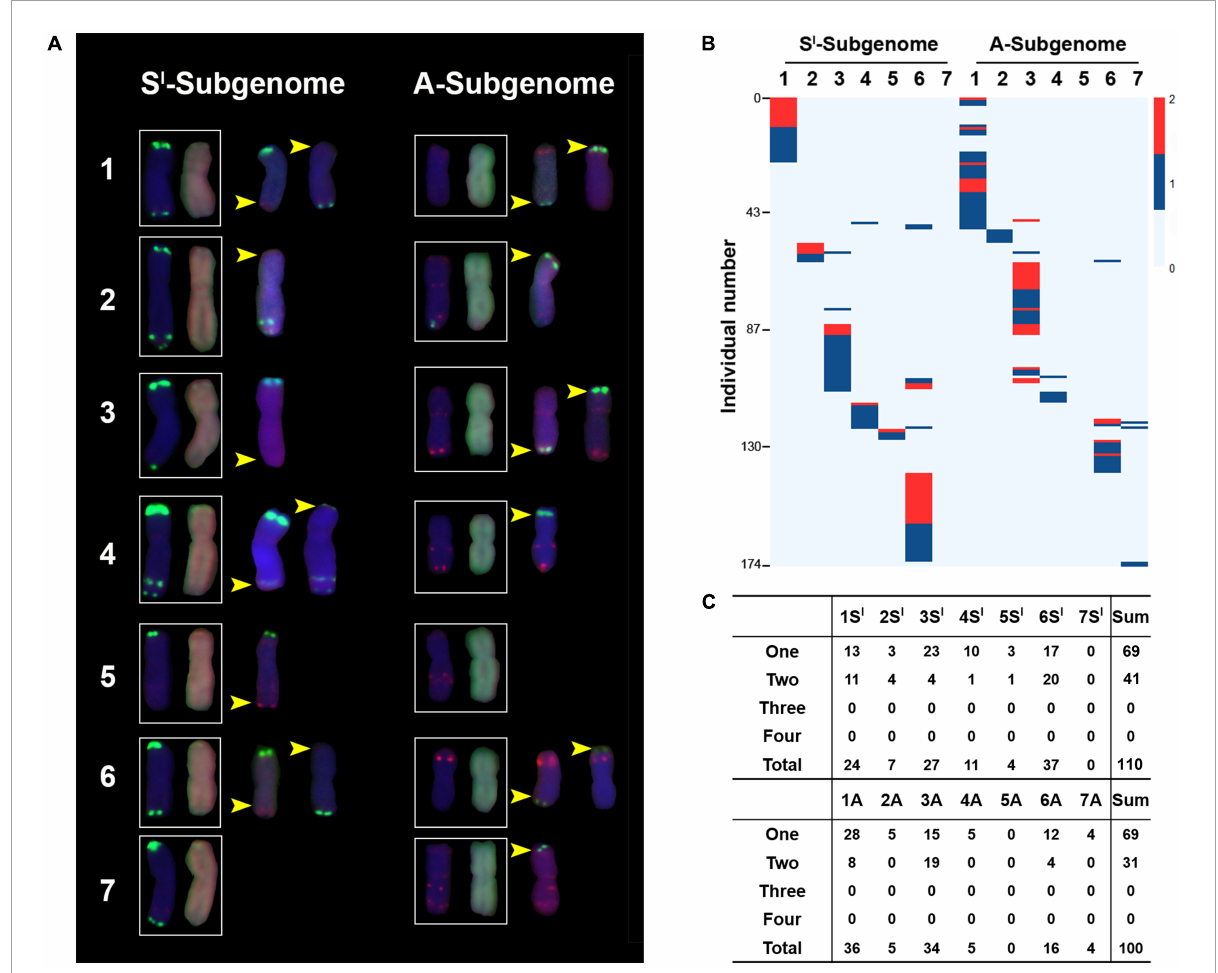
FIGURE4 Structural chromosome variations (SCVs) in the 526 karyotyped individuals. Illustration of representative SCVs occurred to each of the 14 chromosome pairs (A) . The pAs1 (red) and pSc119.2 (green) were used as FISH probes. The genomic DNAs of Ae. longissima (S l S l , red) and T. urartu (AA, green) were used as GISH probes. Yellow arrows denote SCVs. The numbers of individuals containing SCVs occurred to each of the 14 chromosome pairs of S l and A subgenomes, which occurred in a total of 174 individuals (B) . Color key represents with SCVs, which varied from 0 to 2. (C) Detailed numbers of individuals with chromosome copies containing SCVs in each of the 14 chromosome pairs. “One to Four” refer to chromosome